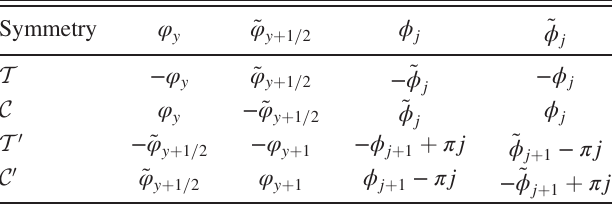
TABLE I. Operation of the antiunitary symmetries on the phase variables. All constant shifts are understood to be given modulo 2 π .